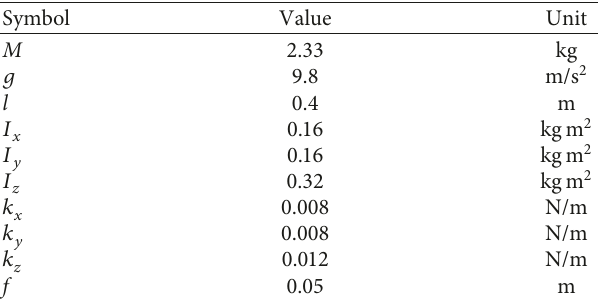
Table 1: The model parameters of the quadrotor UAV in simu- lation [34].